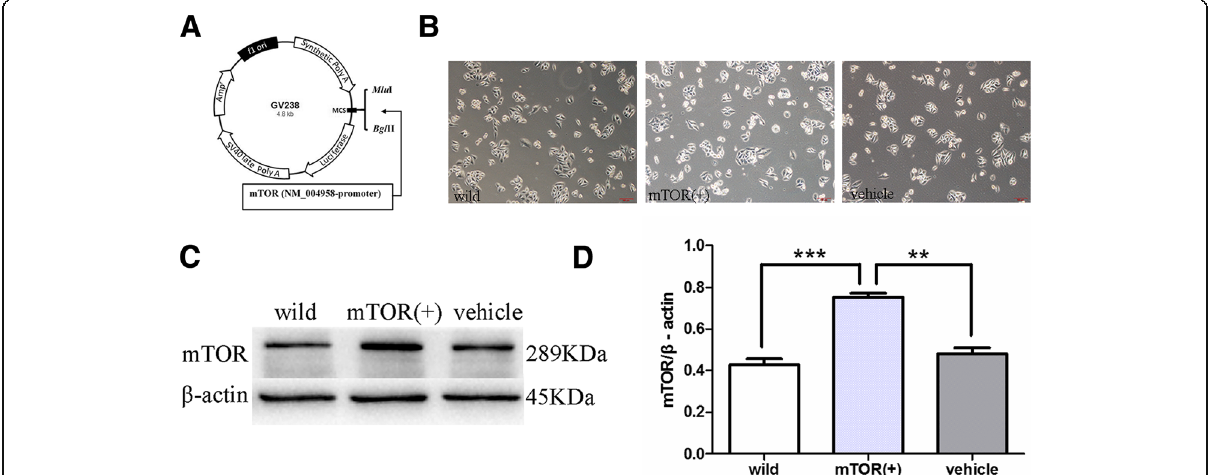
Fig. 1 Generation of the HepG2/mTOR + cells. a Construction of the GV238-mTOR recombinant plasmid. b cell morphology under a microscope (100×). c and d the expression levels of mTOR in the HepG2/mTOR + cells. ( ** P < 0.01, versus vehicle; *** P < 0.001, versus wild type)